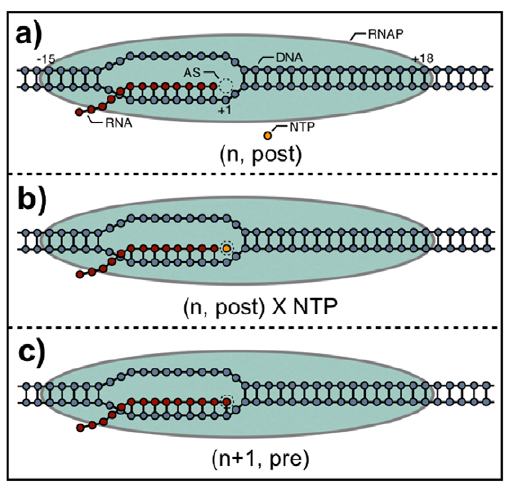
Figure 1. Representation of transcription elongation complex (TEC): The TEC is given by the RNA length, n , and by the relative position of the Active Site, AS , to the 3 9 end of the RNA. a) Post- translocated state: active site free. The TEC structure is given by an RNA- DNA hybrid 8 bp long and by a DNA bubble with 12 bp. b) Post- translocated state, incorporation phase: active site just occupied, NTP being incorporated to RNA. c) Pre-translocated state: active site occupied and the NTP incorporated in RNA. Here, the RNA-DNA hybrid is 9 bp long and the TEC will move one nucleotide forward, returning to a).